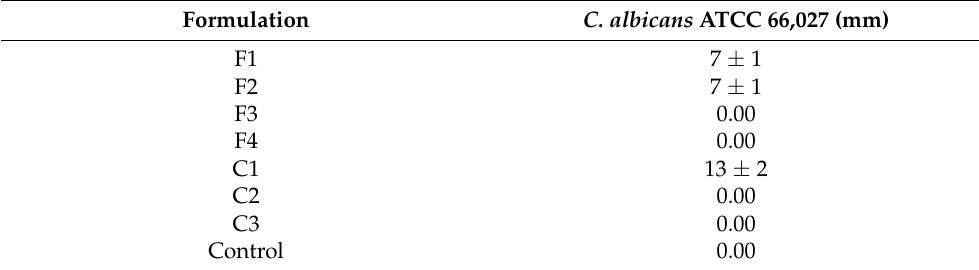
Table 7. The zone of inhibition diameters of the prepared hand sanitizers compared to three commer- cially available hand sanitizers (C1, C2, and C3) against C. albicans . The results represent the mean of three independent experiments ± SD ( n = 3). Only the clove hand sanitizers (F1 and F2) and the ethanol-based control (C1) showed anti-yeast activity against C. albicans , but with variable